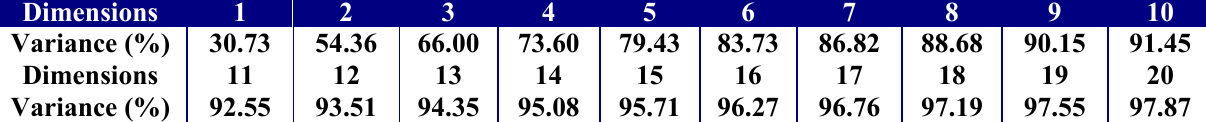
Table 5. The cumulative variances of PCA-transformed new features.